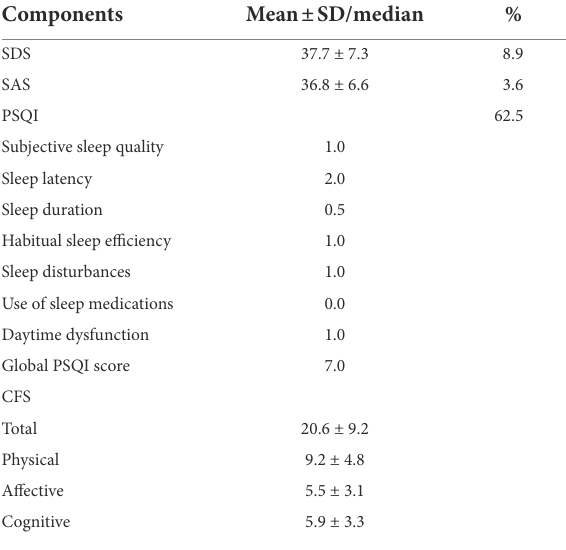
TABLE 2 The scores and the prevalence of depression, anxiety, sleep, and fatigue in patients with breast cancer during COVID-19 pandemic.